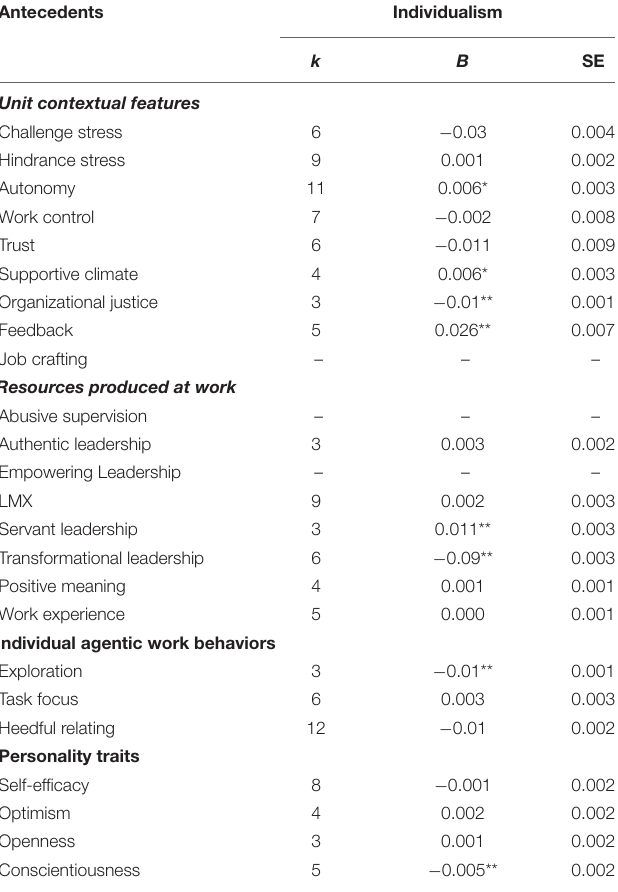
TABLE 6 | The moderating effect of national culture on the relationships between thriving at work and its antecedents.